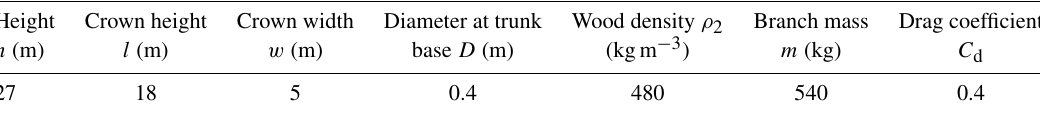
Table 1. Model parameters used in the numerical simulations of the tree response. Parameters are derived from data contained in Kantola and Mäkelä (2004) and Bartelt et al. (2018a).